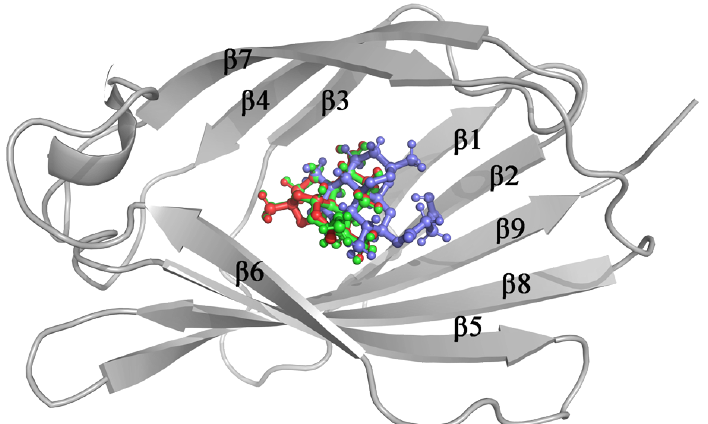
Figure 3. Structure of docked ligands at the binding site of MD-2, artemisinin (red stick), artemether (green stick) and artesunate (blue